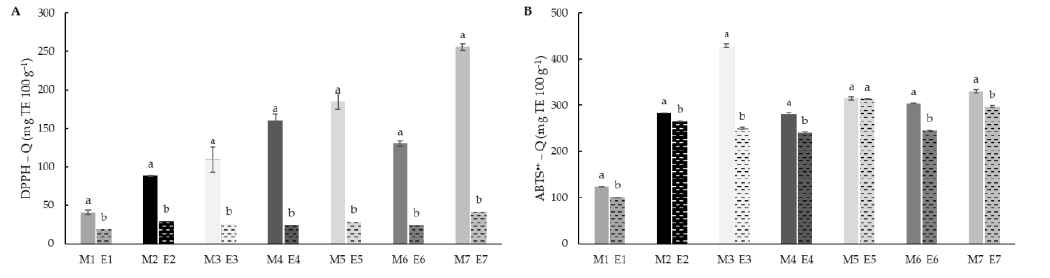
Figure 6. Quencher DPPH ( A ) and Quencher ABTS • + ( B ) values of native (M1–M7) and extruded (E1–E7) blend flour samples. Results were expressed as mg Trolox equivalent (TE) 100 g − 1 of dry matter. Different letters indicate significant differences ( p < 0.05) between non-extruded (M) and extruded (E) flours, for each blend formulation. M1/E1 (100RF), M2/E2 (12.5WTF/12.5 BTF/75RF), M3/E3 (25WTF/75RF), M4/E4 (25BTF/75RF), M5/E5 (25WTF/25 BTF/50RF), M6/E6 (50WTF/50RF), M7/E7 (50BTF/50RF).